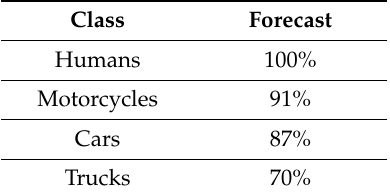
Table 7. Cases 1, 3, and then 4 prediction